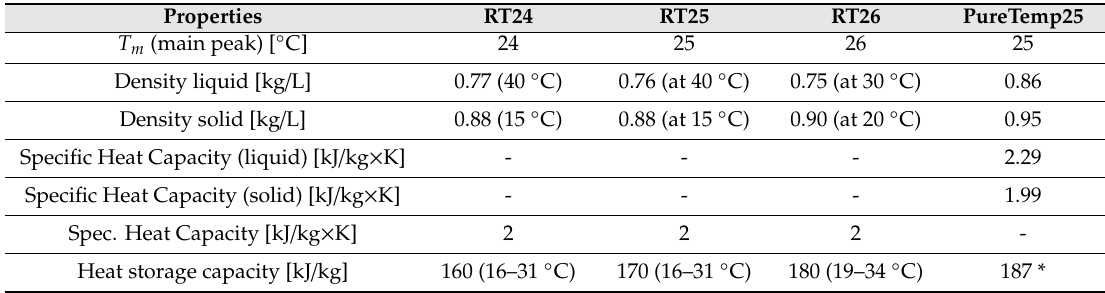
Table 1. Properties of RT24, 25, 26 and PureTemp25 as given by manufacturers´ datasheets [36,37].